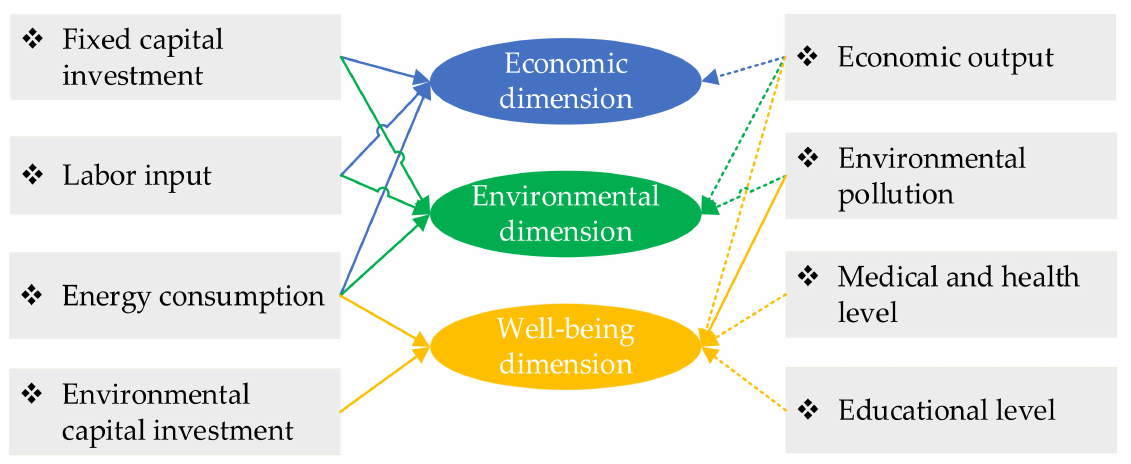
Figure 3. The measurement indicators of urban energy performance in different dimensions. Note: the blue, green and yellow arrow lines represent the measurement indicators of economic, environmental, and well-being dimensions, respectively. The solid lines represent the input indicators, and the dotted lines represent the output